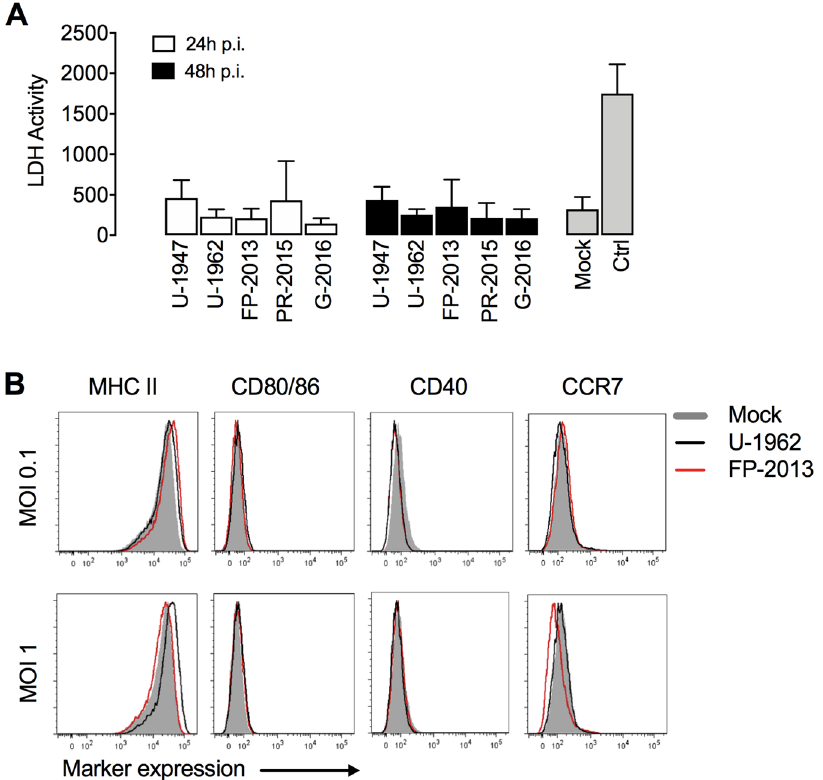
Figure 4. ZIKV infection is not inducing cell death nor activation of MoDCs. ( A ) Cytopathic effect of ZIKV infection of MoDCs assessed by LDH activity 24, and 48 h after mock-treatment or infection with five ZIKV strains at a MOI 0.1 TCID 50 /cell. Supernatant of dead cells was used as a positive control. Data are presented as mean of MoDCs generated from 4 independent blood donors. ( B ) Expression levels of the activation markers MHC class II, CD80/86, CD40 and CCR7 measured by flow cytometry upon MoDCs mock-treated or infected with U-1962 and FP-2013 at a MOI of 0.1 and 1 TCID 50 /cell. The data shown are representative of MoDCs generated from 3 independent blood